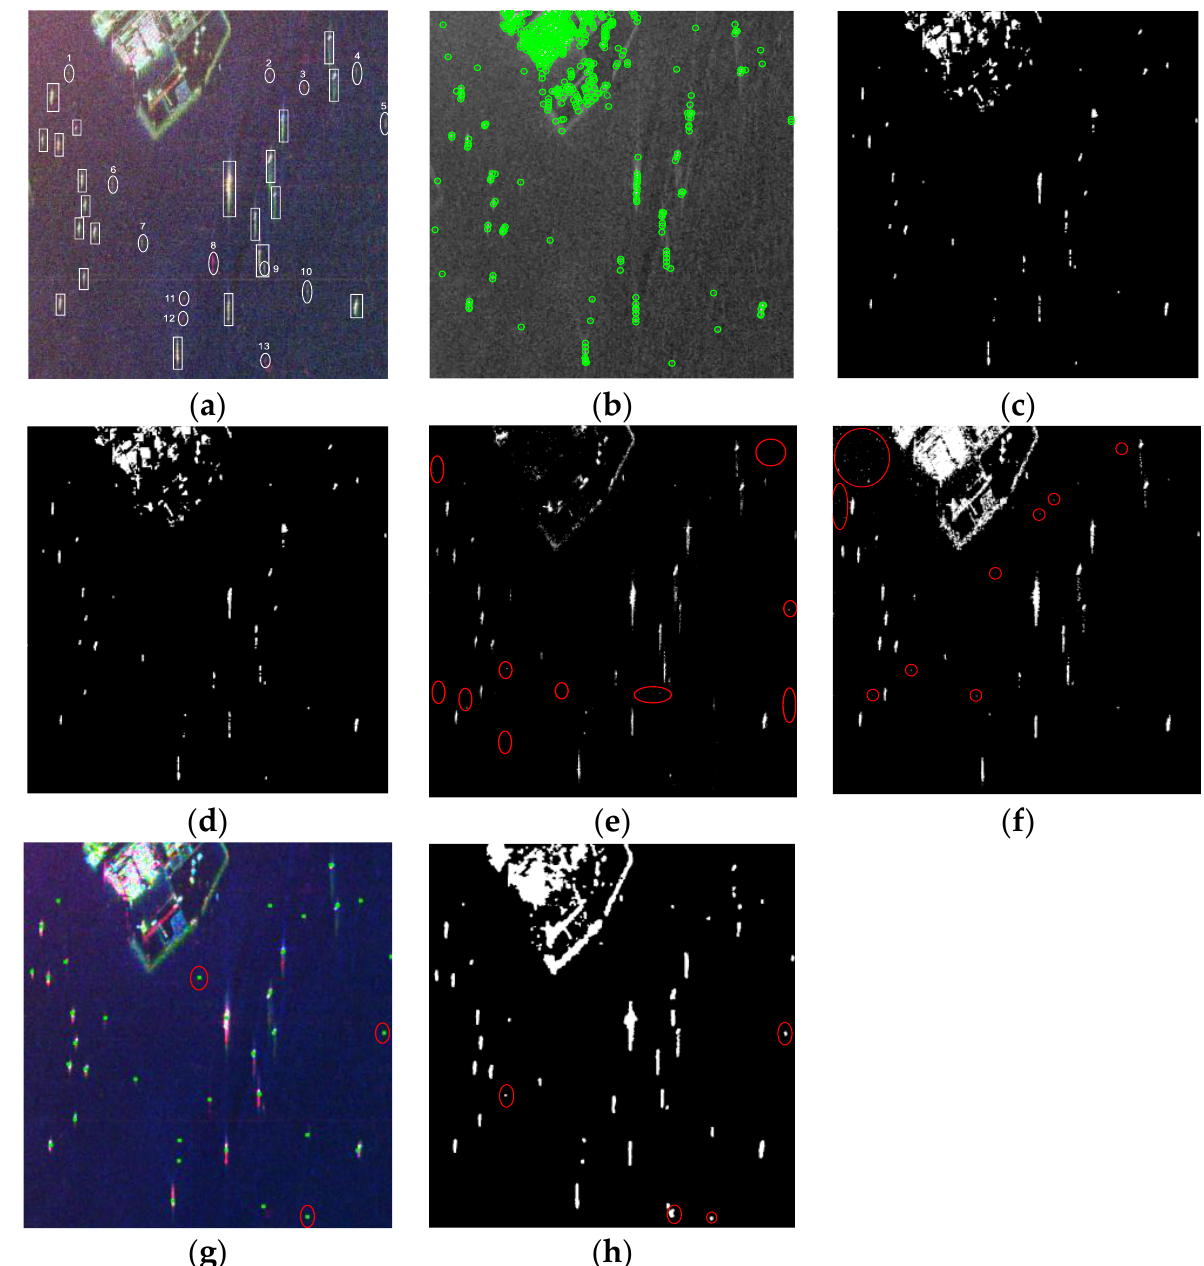
Figure 10. R2 regions: ( a ) Pauli pseudo-color image with potential targets manually marked. White rectangles indicate the strong targets and white ellipses indicate the comparatively weak targets. ( b ) Keypoints extracted by PolSAR-SIFT keypoint detector. ( c – h ) Detection results of the proposed method, the PNF, the PWF, the RS, the SD-LSMDRK and the SD-SLLIM, respectively. The main false alarms are marked by the red circles.